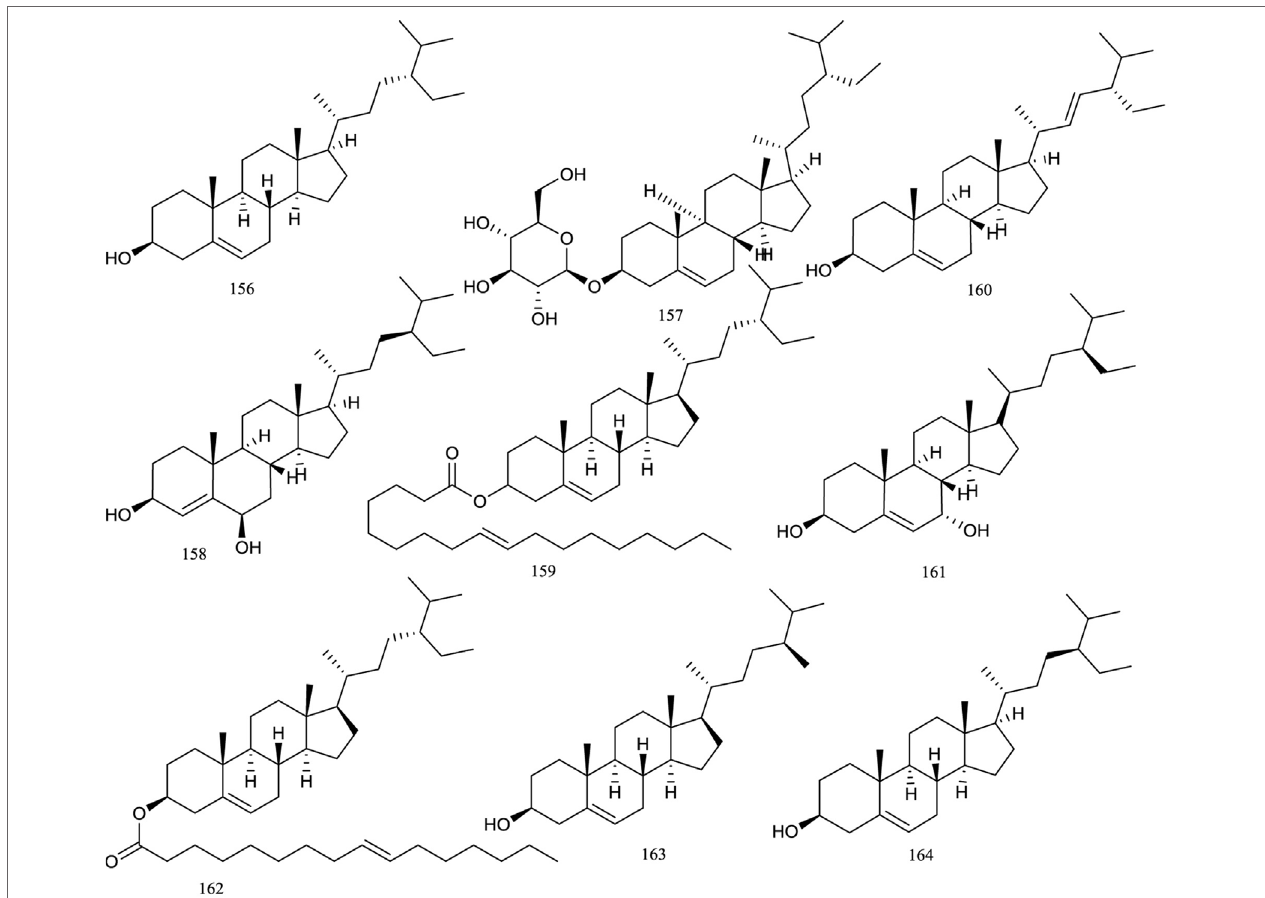
FIGURE 7 | Chemical structures of steroids (156–154) isolated from R. chingii